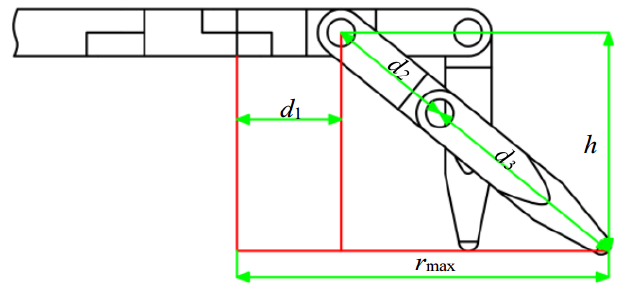
Figure 6. Definition of r max with respect to d 1 , d 2 , and d 3